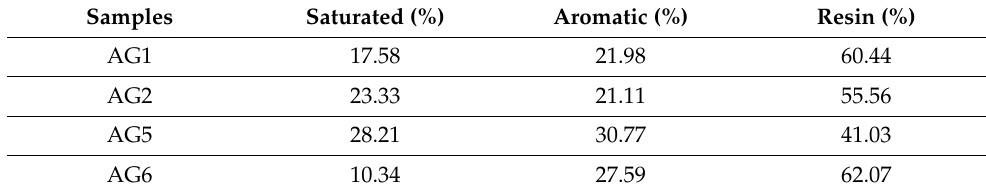
Table 5. Values of liquid